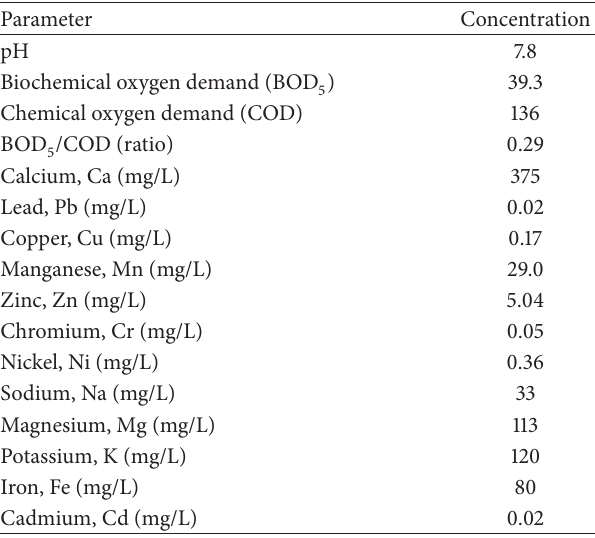
Table 5: Physical and chemical properties of the leachate.